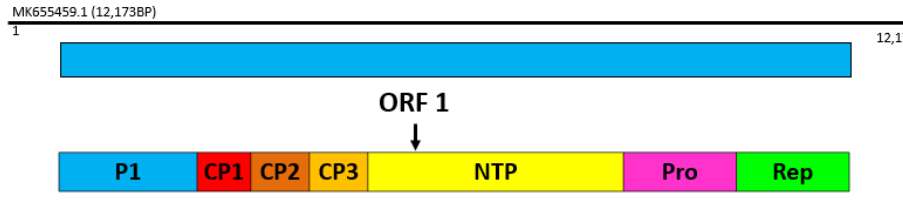
5 of 17 Figure 1. Genomic organization of RTBV-SP (RTBV: accession no. MK552377.1). The open reading frames are shown in blue (ORF 1, ORF 2, ORF 3, and ORF 4). 3.2. Analysis of RTSV Genome RTSV-SP genome has 12,173 nucleotides in length (accession no. MK655459.1) with a G+C content of 45.82 percent. The nucleotide sequence of the RTSV-SP isolate was found to be 86.22–96.02% identical with other RTSV genomes available in the Genebank data- base, according to searches through blastn. The highest percentage of identity to RTSV-SP